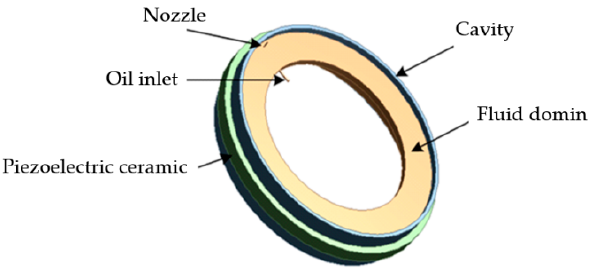
Figure 18. Finite element model of the piezoelectric microjet (Adapted from[172]).